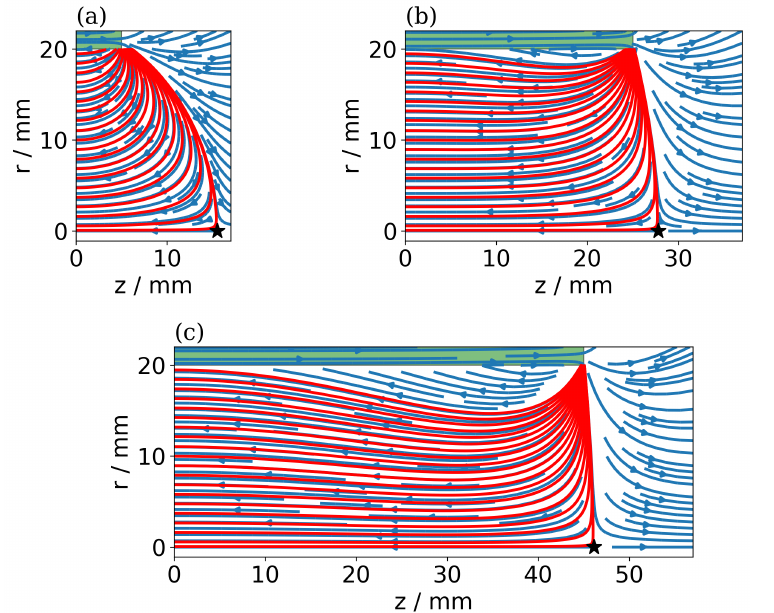
Figure 3. A ring magnet (green rectangle) is depicted with radius R = 20mm for different lengths L centered around the symmetry axis ( r = 0). The three geometries have varying lengths ( a ) L = 10mm, ( b ) L = 50mm and ( c ) L = 90mm. In each plot, the field lines are drawn in blue. The figure shows only one half of the axially symmetric system, neglecting negative z . Red lines start from various radii r 0 , where z = 0. These are integrated along the magnetic field until they reach the wall, i.e., when they exceed R. The star ( ★ ) denotes the maximum z coordinate of the separatrix z sep on the axis r =